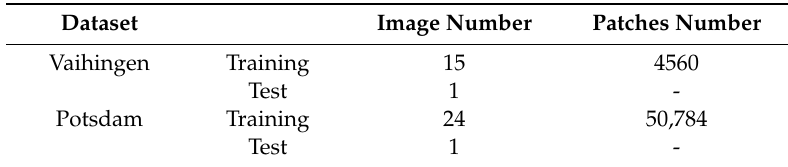
Table 3. Training and testing